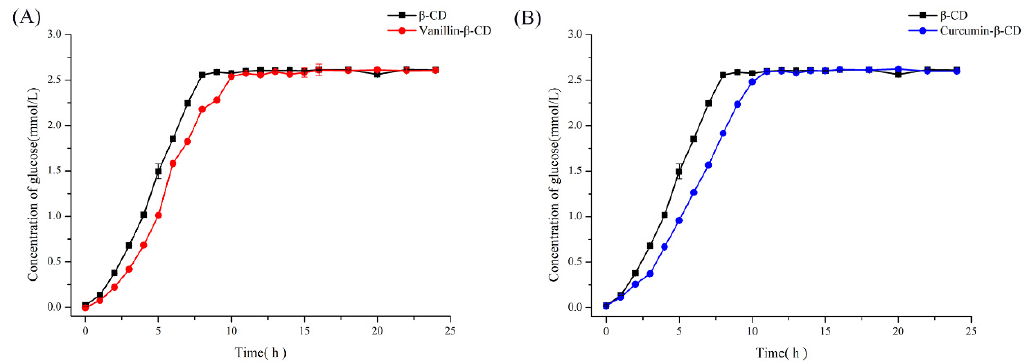
Figure 4. The release of glucose from ( A ) β -CD and the vanillin- β -CD complex and ( B ) β -CD and the curcumin- β -CD complex by dual enzyme action with identical amounts of β -CGTase and AG.